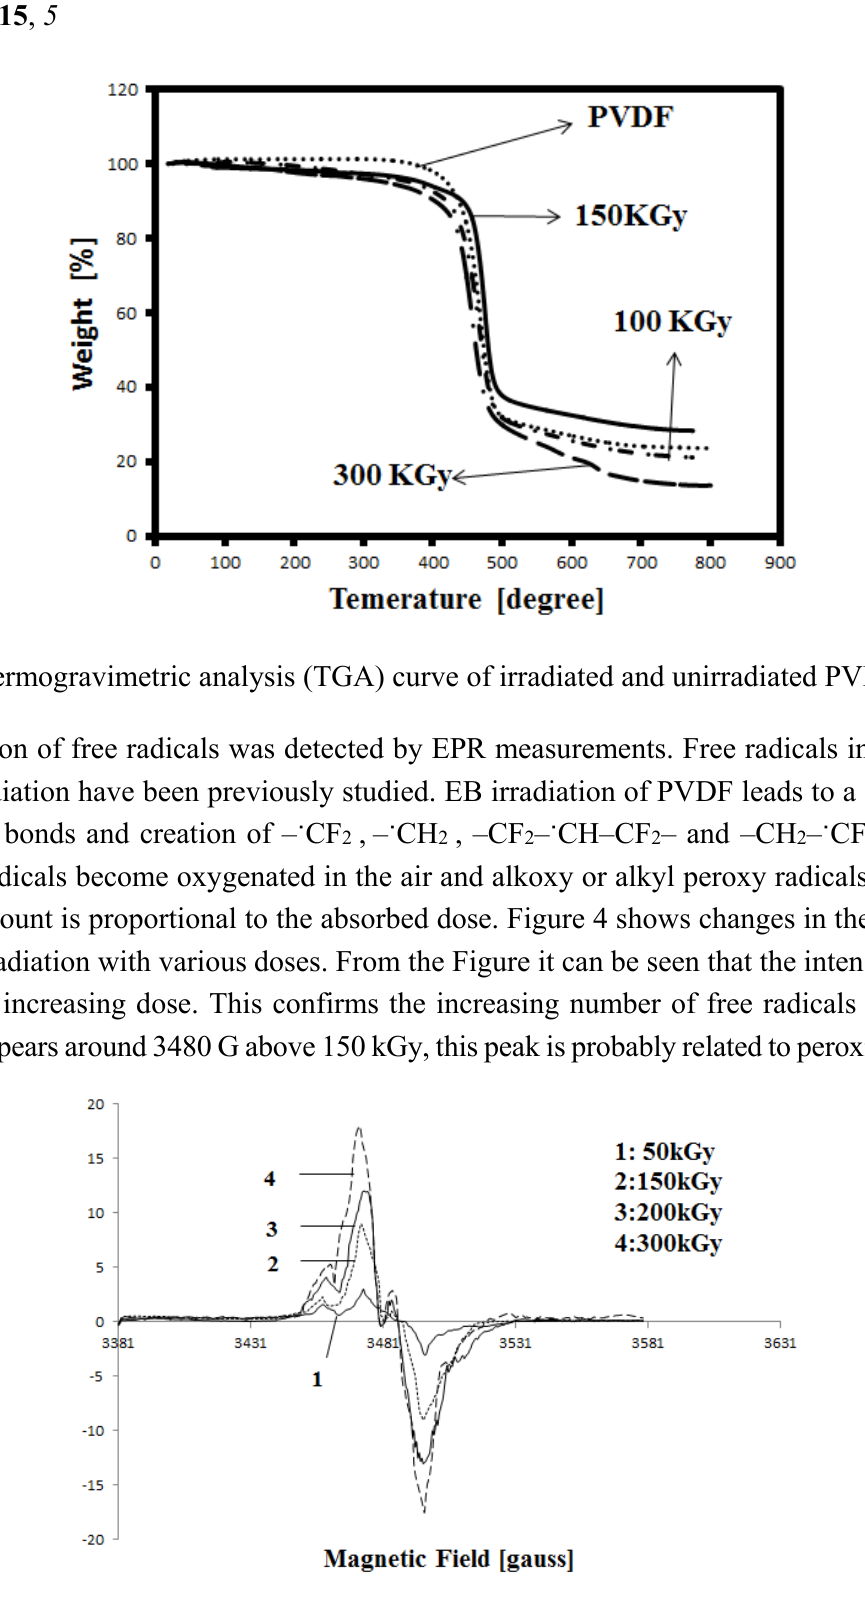
Figure 4. Electron paramagnetic resonance (EPR) curve of irradiated PVDF membrane by 50 kGy, 200 kGy and 300